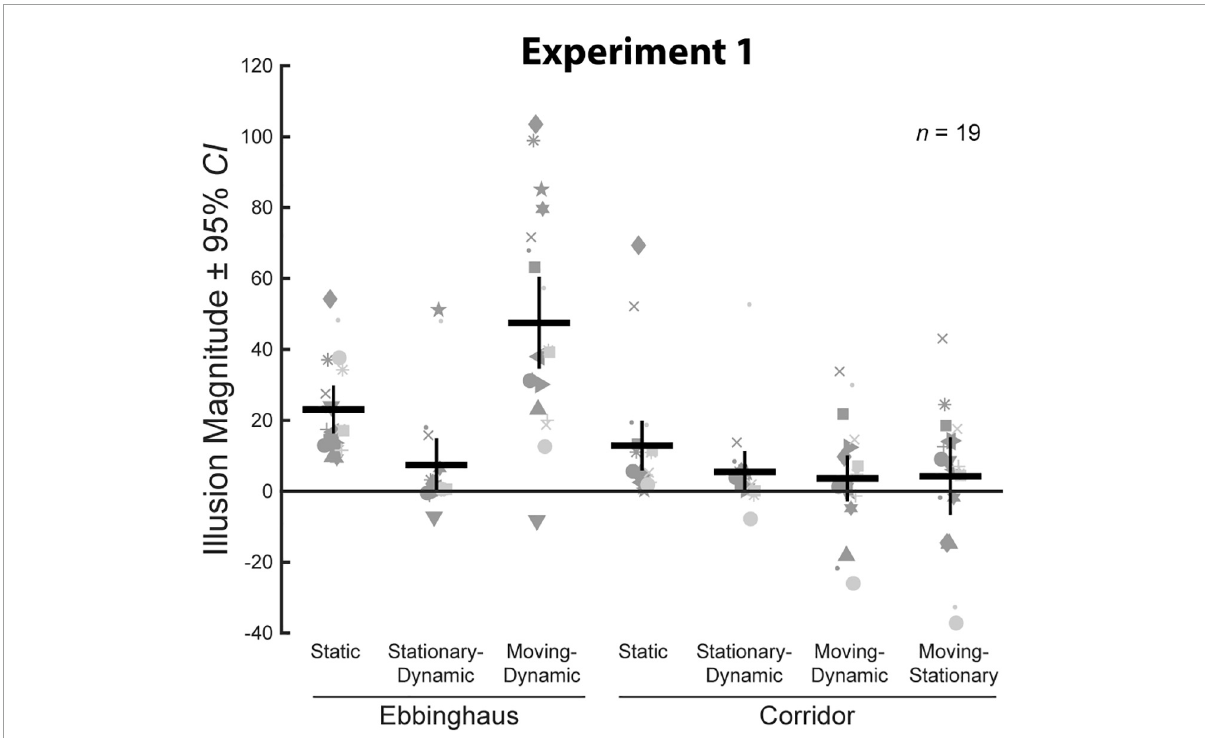
FIGURE3 Illusion magnitudes for the seven conditions with a surrounding context in Experiment 1. Gray markers indicate individual participant data. Black horizonal lines indicate group means and black vertical lines represent 95% CIs with between-subject variance removed. Statistical comparisons against zero and across conditions are summarized in Table 1